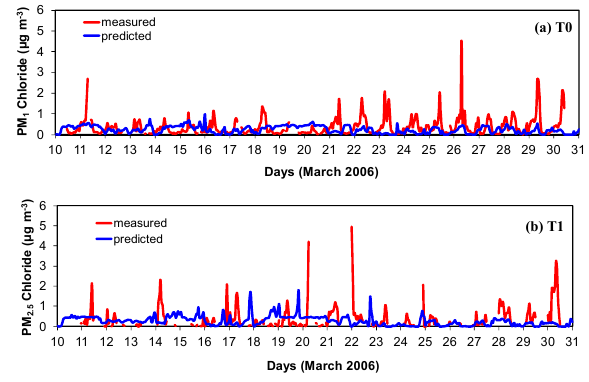
Fig. 8. Comparison of model hourly predictions against measure- Figure 8: Comparison of model hourly predictions against measurements for PM 1 chloride taken ments for PM 1 chloride taken at T0 (a) and PM 2 . 5 chloride taken at at T0 (a) and PM 2.5 chloride taken at T1 (b) during the MILAGRO campaign. T1 (b) during the MILAGRO campaign.